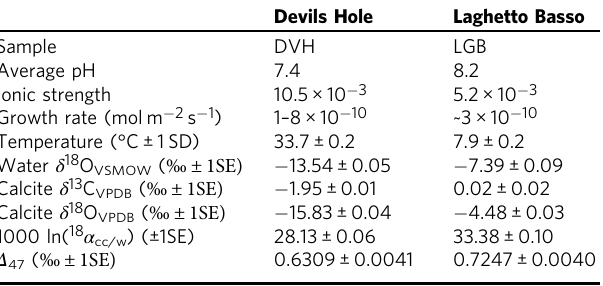
Table 1 Crystallization conditions and stable-isotope compositions of water and calcite from Devils Hole and Laghetto Basso Devils Hole